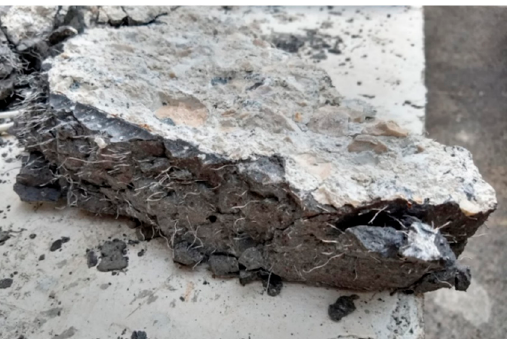
Figure 10. Detailed image of a representative interface piece removed from specimen S2.